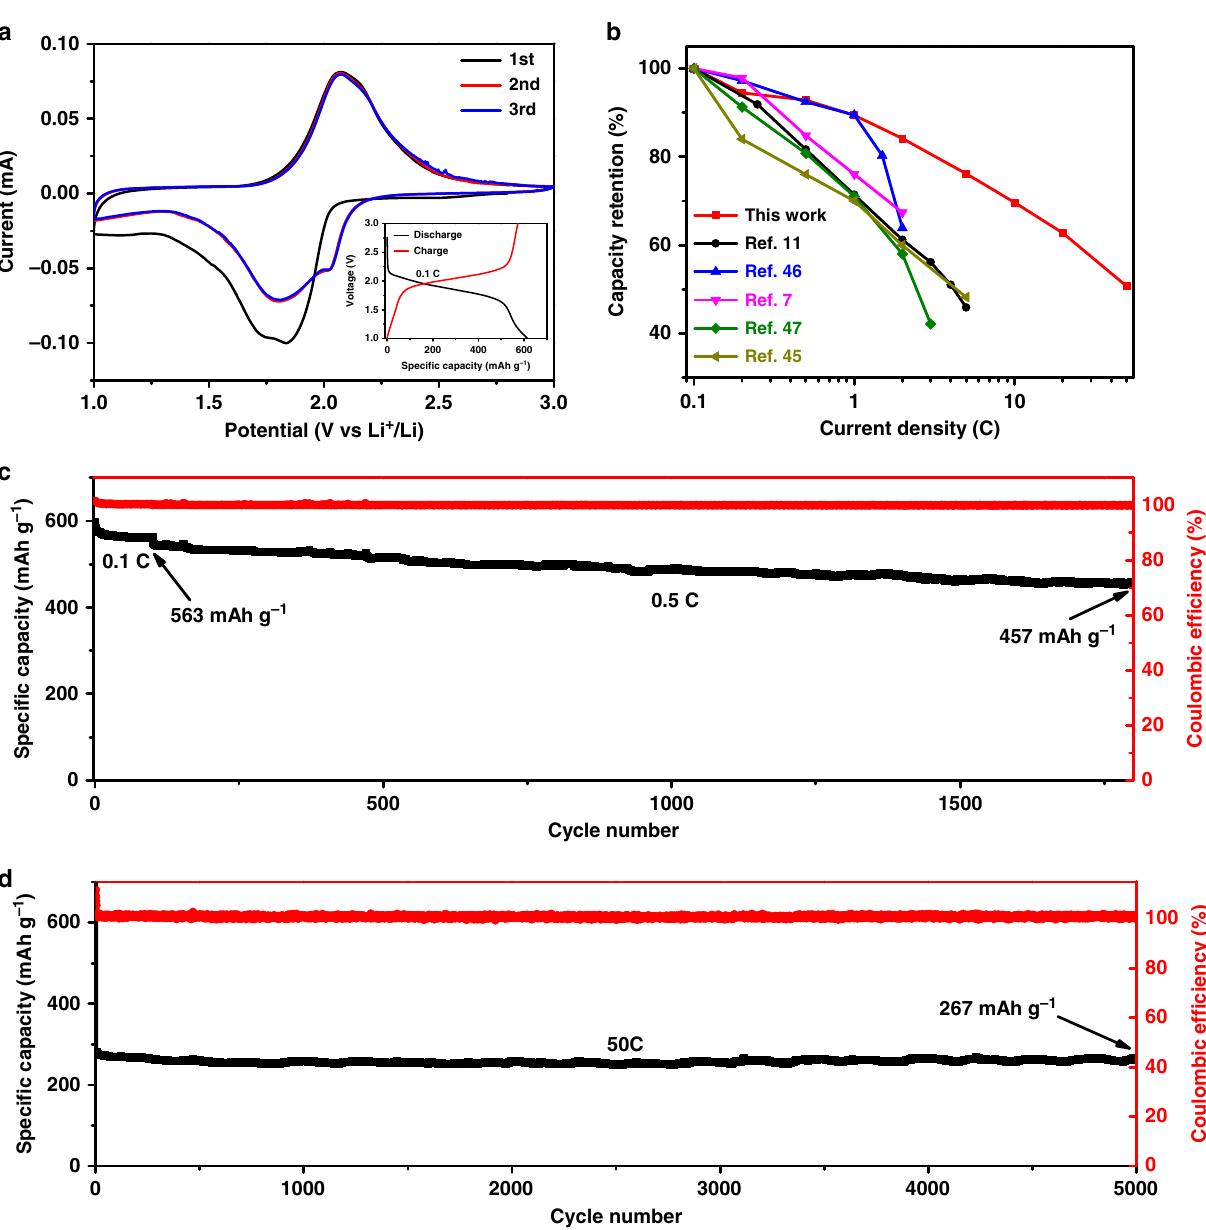
Fig. 4 Lithium-ion-storage behaviour of a Se@Co SA -HC cathode. a CV curves of Se@Co SA -HC at a scan rate of 0.1 mV/s (the fi rst three cycles) (inset: discharge-charge voltage pro fi les of Se@Co SA -HC at 0.1 C). b The rate capability of Se@Co SA -HC compared with other reported Se-based electrodes for Li – Se battery. c Cycling performance and Coulombic ef fi ciency at 0.1 C for 100 cycles and then 0.5 C for 1700 cycles. d Long cycling performance and Coulombic ef fi ciency at 50 C for 5000